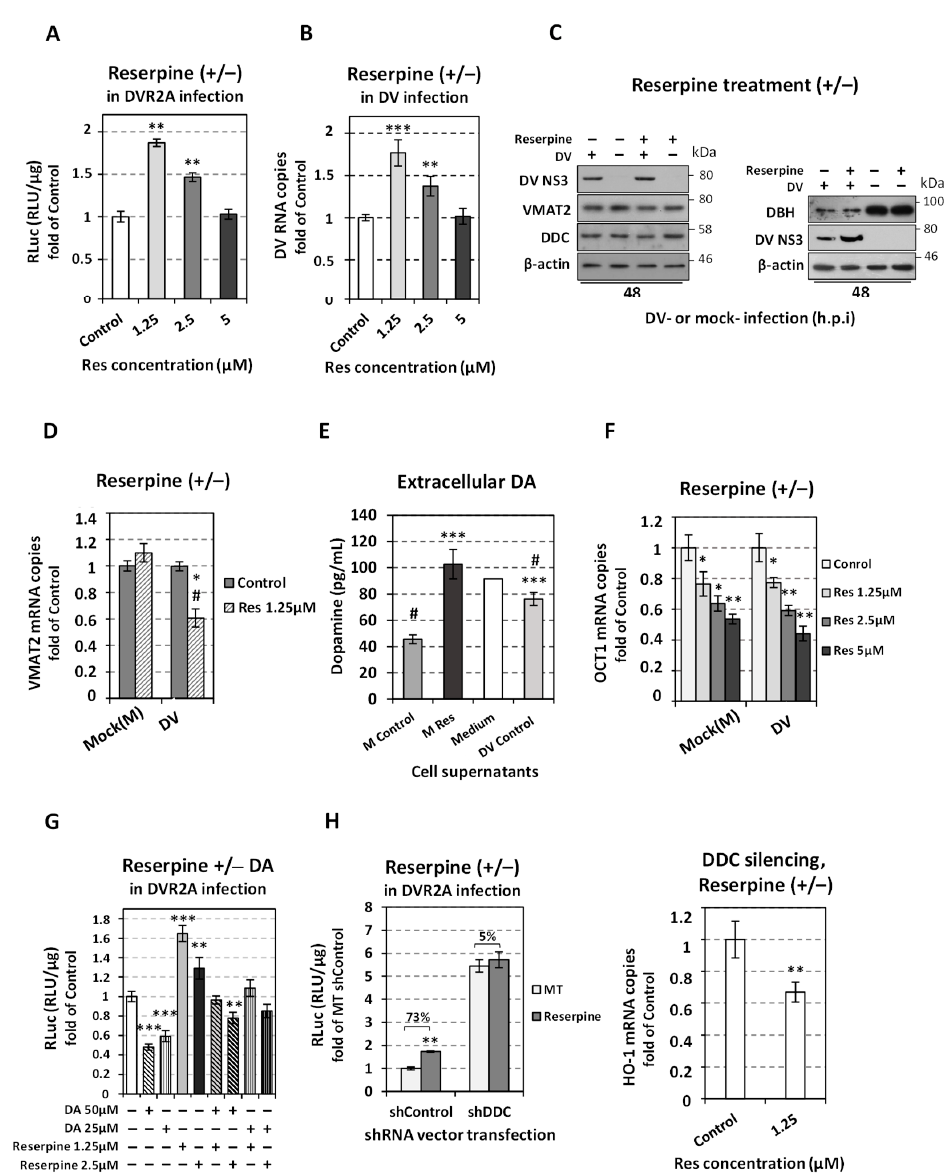
Figure 6. Effect of VMAT-inhibitor reserpine on DV replication. ( A – G ) Huh7 cells were inoculated with the reporter DVR2A (MOI = 0.1) (( A , G , H ) left panel) or DV (MOI = 0.1) ( B – F ) virus, or were mock-infected (mock, M), for 4 h and then treated with reserpine (Res), or mock-treated (Control) for 48 h. ( A , B ) For different concentrations of reserpine applied: ( A ) Levels of Renilla luciferase activity, indicative of DV replication, were calculated as RLU/ µ g of total protein amount. ** p < 0.001 vs. Control. ( B ) RT-qPCR analysis was performed to determine DV plus-strand RNA levels. Control mock-infected cell values were set as one. The mean values ± standard deviations from three independent experiments in triplicate are presented. ** p < 0.01 vs. Control, *** p < 0.001 vs. Control. ( C , D ) The result of reserpine treatment on DV NS3 and VMAT2 protein expression. Huh7 cells were infected with DV (MOI = 0.1) or not (mock-infected) for 4 h and then were treated with reserpine (1.25 µ